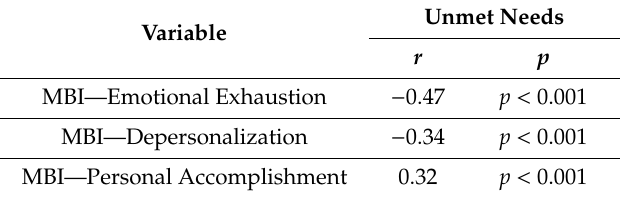
Table 5. Analysis between subscales Maslach Burnout Inventory (MBI) of the unmet